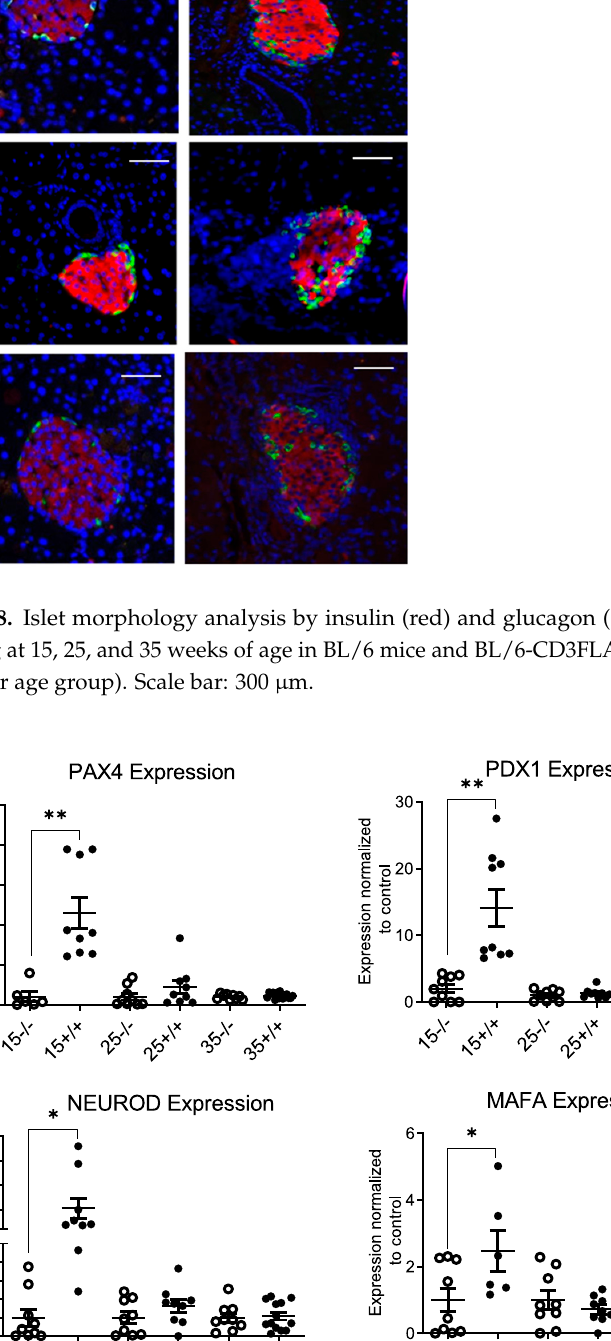
Figure 10. Immunofluorescence labelling of pancreatic tissue sections from 15-week-old mice representing Insulin + Ki67 + beta cells in the islet of the transgenic mice. Quantitative analysis indicates the percentage of Ki67 + cells based on Ki67 labelling of 15-week-old BL/6 and BL/6-CD3FLAGmIR pancreatic tissue ( n = 3 mice, n = 23 islets analyzed per mouse). -/- indicates BL/6 mice and +/+ indicates BL/6-CD3FLAGmIR mice. Unpaired student t test: * p ≤ 0.05.